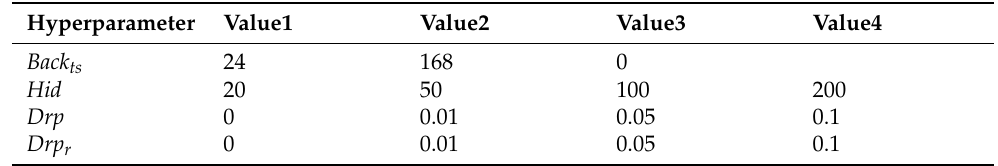
Table 1. Assigned values of